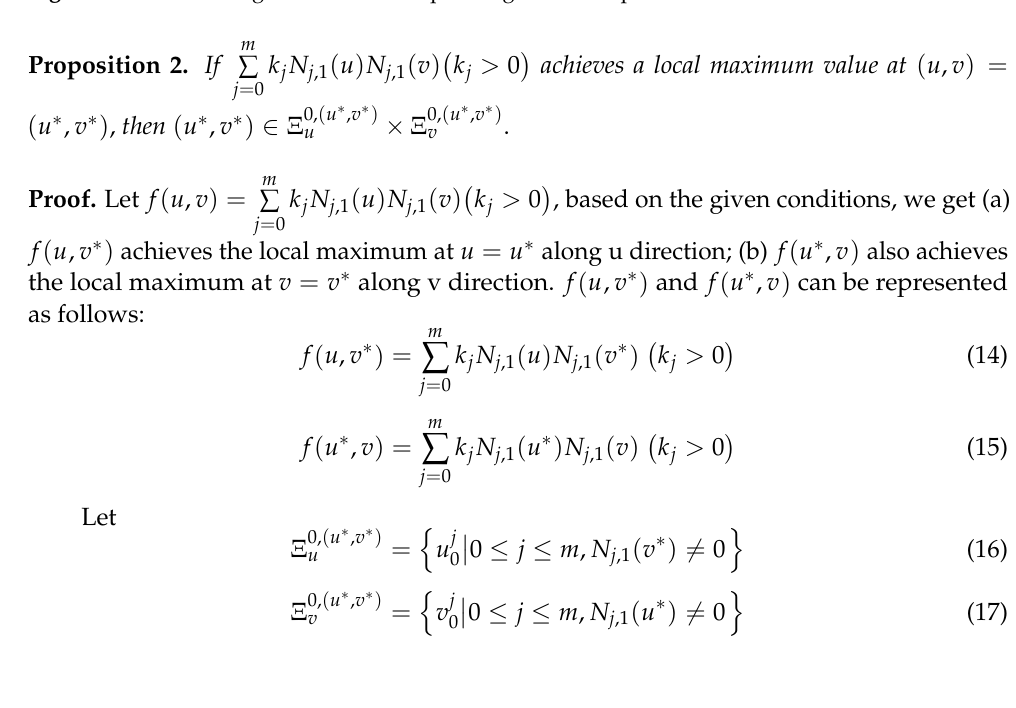
Figure 3. Extension edges and the corresponding extension